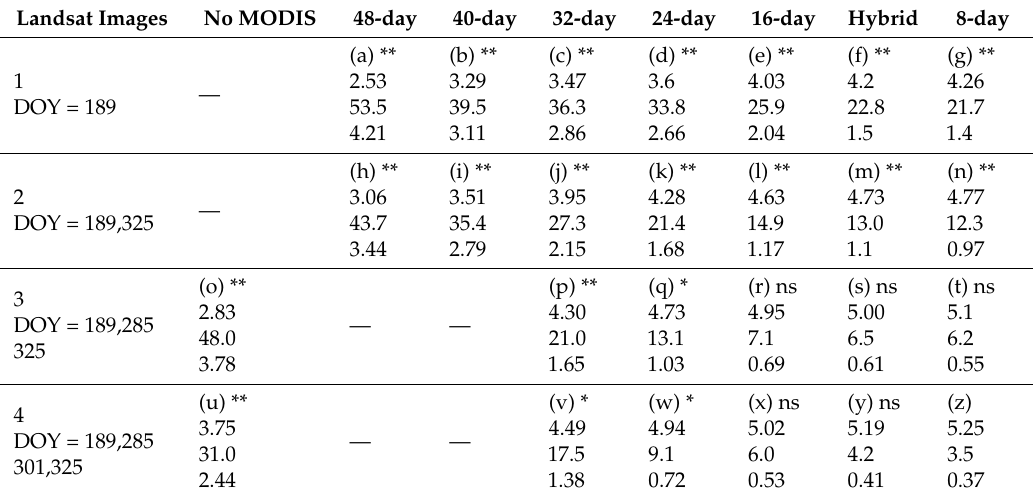
Table 4. Crop water consumption and ET estimates for different experiments 1